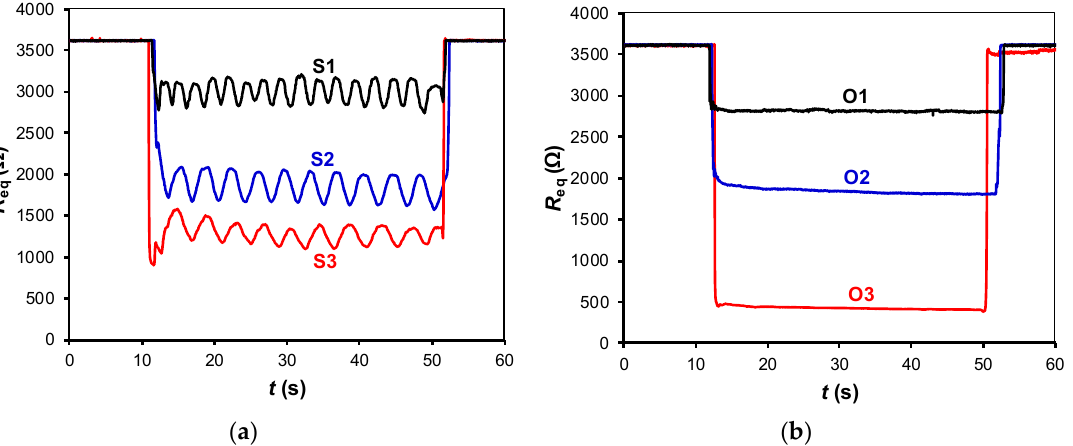
Figure 6. Experimental resistance variations monitored by the DIC in Figure 2a when over the chair we had: ( a ) subjects of different weight and age in the sitting posture P2; ( b ) objects of different weight. The test was carried out at f s = 60 Sa/s with C = 2.2 µF.